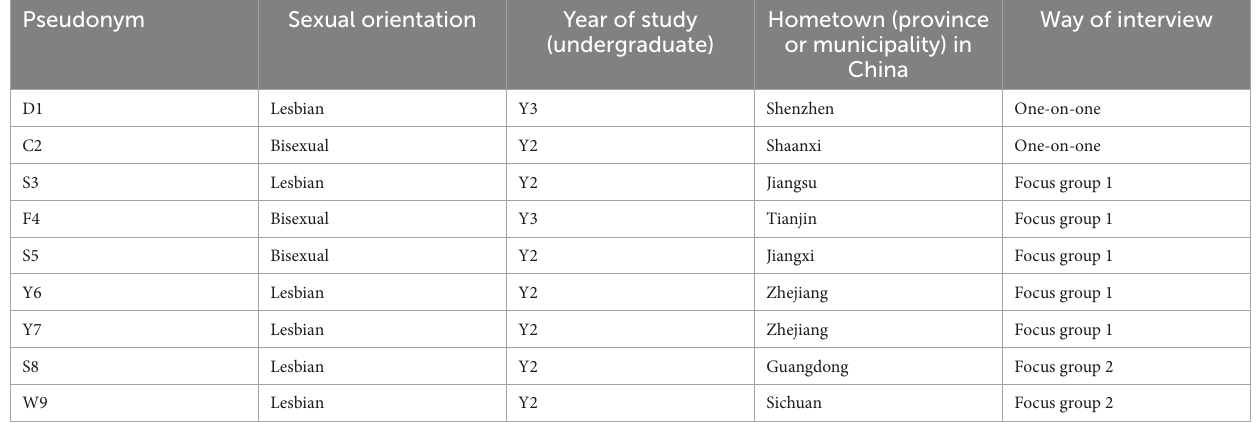
TABLE 1 Information of student